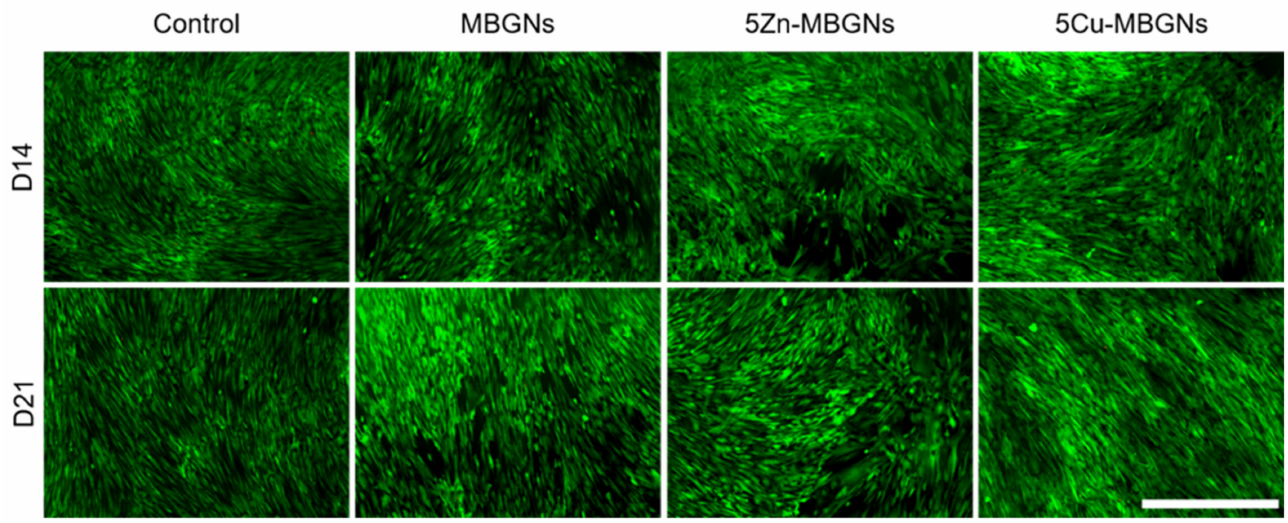
Figure 2. Representative live/dead-assay for the MBGN groups and the control group after an incubation time of 14 (D14) and 21 (D21) days. Viable cells are shown in green, compromised cells in red. Scale bar (bottom right corner) refers to 1000 µ m and applies to all images. Magnification: